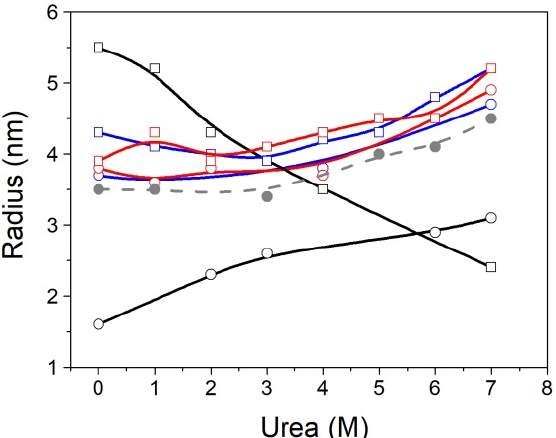
Figure 6 . Apparent hydrodynamic radius of MBD and NTD-MBD-ID measured by DLS of MBD Figure 6. Apparent hydrodynamic radius of MBD and NTD-MBD-ID measured by DLS of MBD